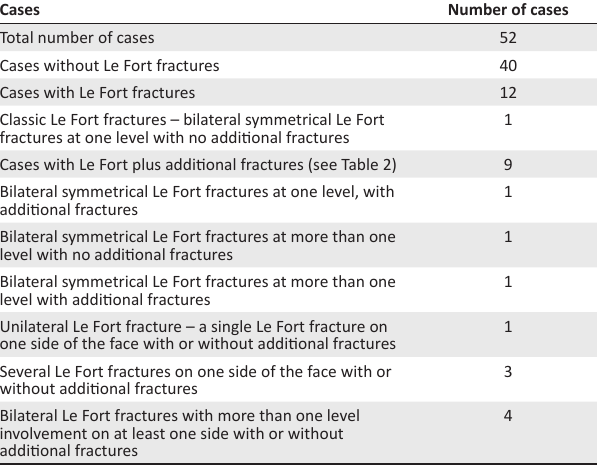
TABLE 1: Cases of facial bone fractures at IALCH between April 2007 and March